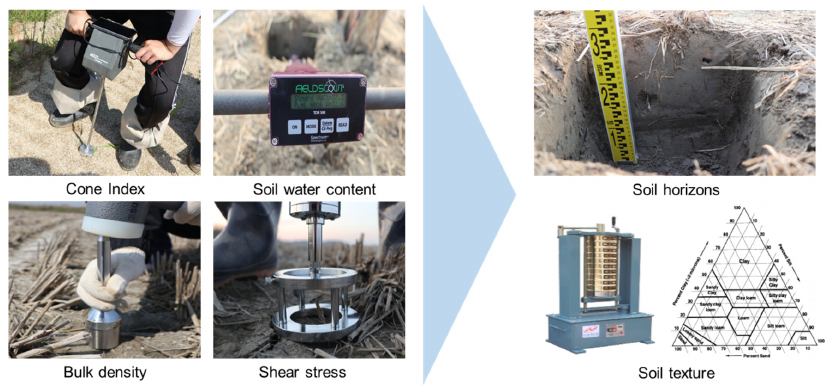
Figure 2. Overall test procedure of the soil property measurement.